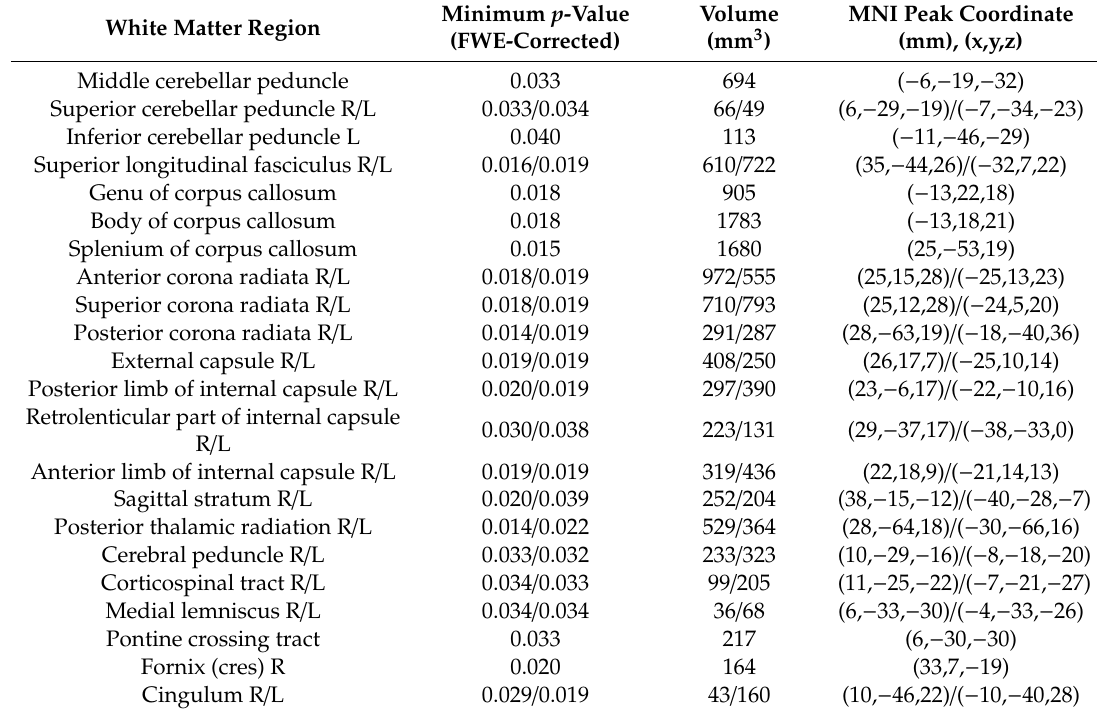
FWE = Family-wise error; L = left; R = right. The column volume represents the volume from the atlas region with significant results. No regions with a volume equal or lower than 30 mm 3 were included in this table. Table A9. White matter regions from the ICBM-DTI-81 White Matter Atlas for which significant increased RTOP values were found in CM compared to EM including the duration of the migraine, presence of aura and medication overuse headache as